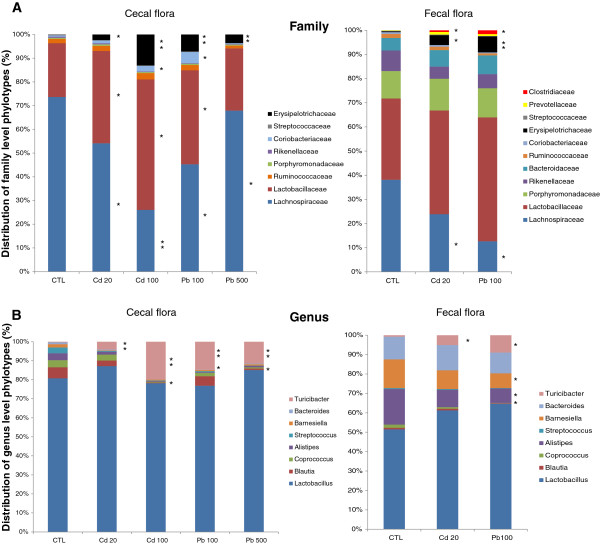
Distribution of bacterial subgroups in the cecum content and fecal pellets of mice exposed for 8 weeks to Cd (20 or 100 mg L-1) or Pb (100 or 500 mg L-1) salts via their drinking water. (A) Family-level and (B) genus-level. 16S rRNA-base analyses were derived from 454/Roche multitag pyrosequencing. Data are expressed as the mean percentage abundance (n = 5 animals per group). Only operational taxonomic units (OTU’s) present in dominant families (> 0.1%) were considered. *: p < 0.05 and **: p < 0.01: significantly different from the control group (water with no added Cd or Pb) for the corresponding taxa. The color code is defined in the inset on the right of the Figure.